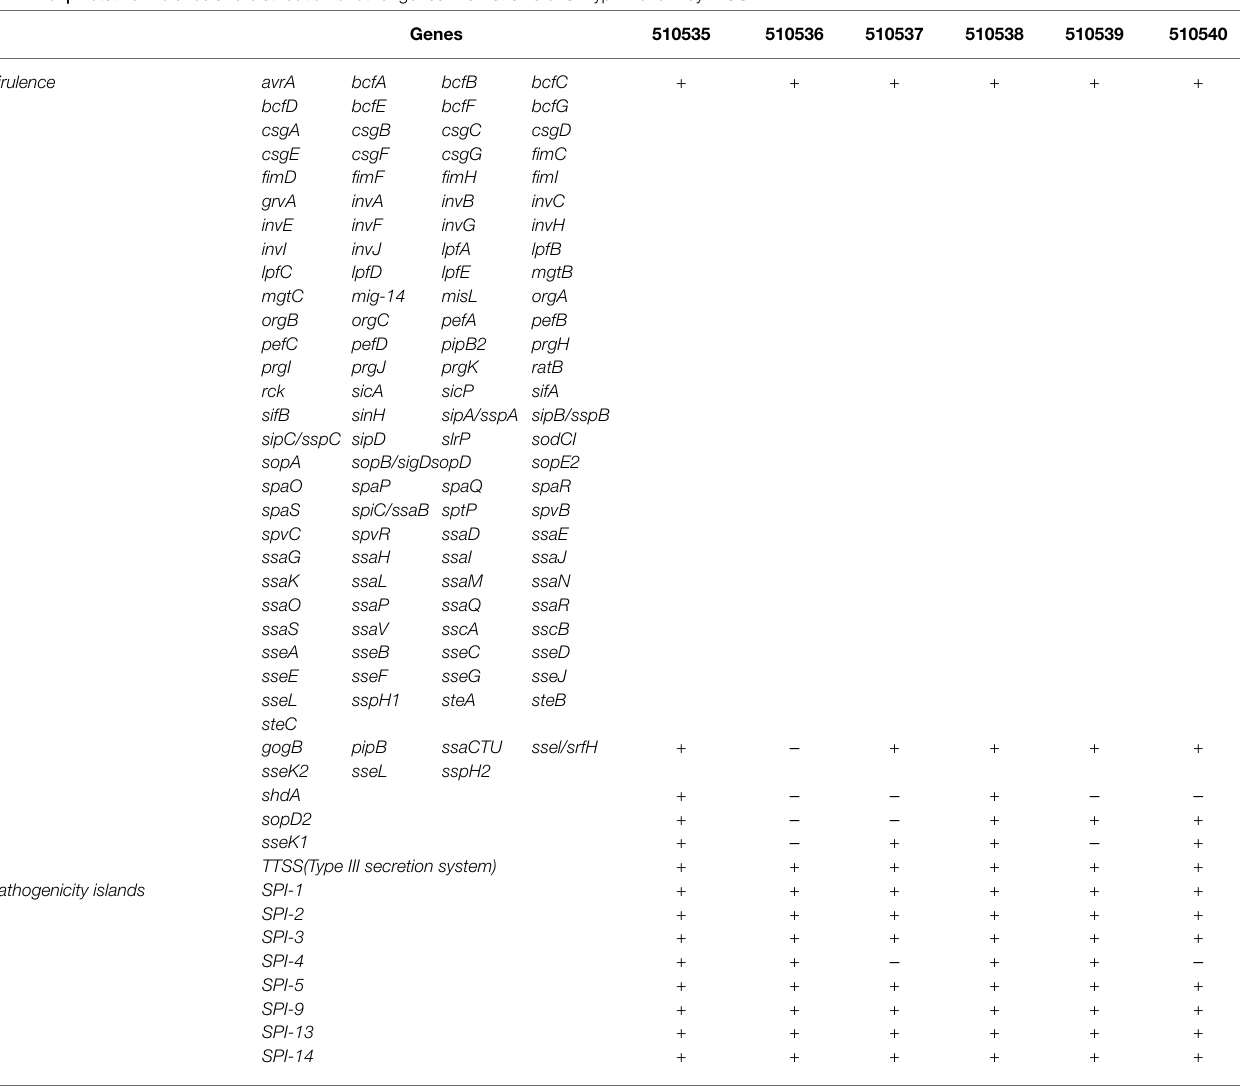
TABLE 6 | Putative virulence and distribution of other genes in six strains of S. Typhimurium by